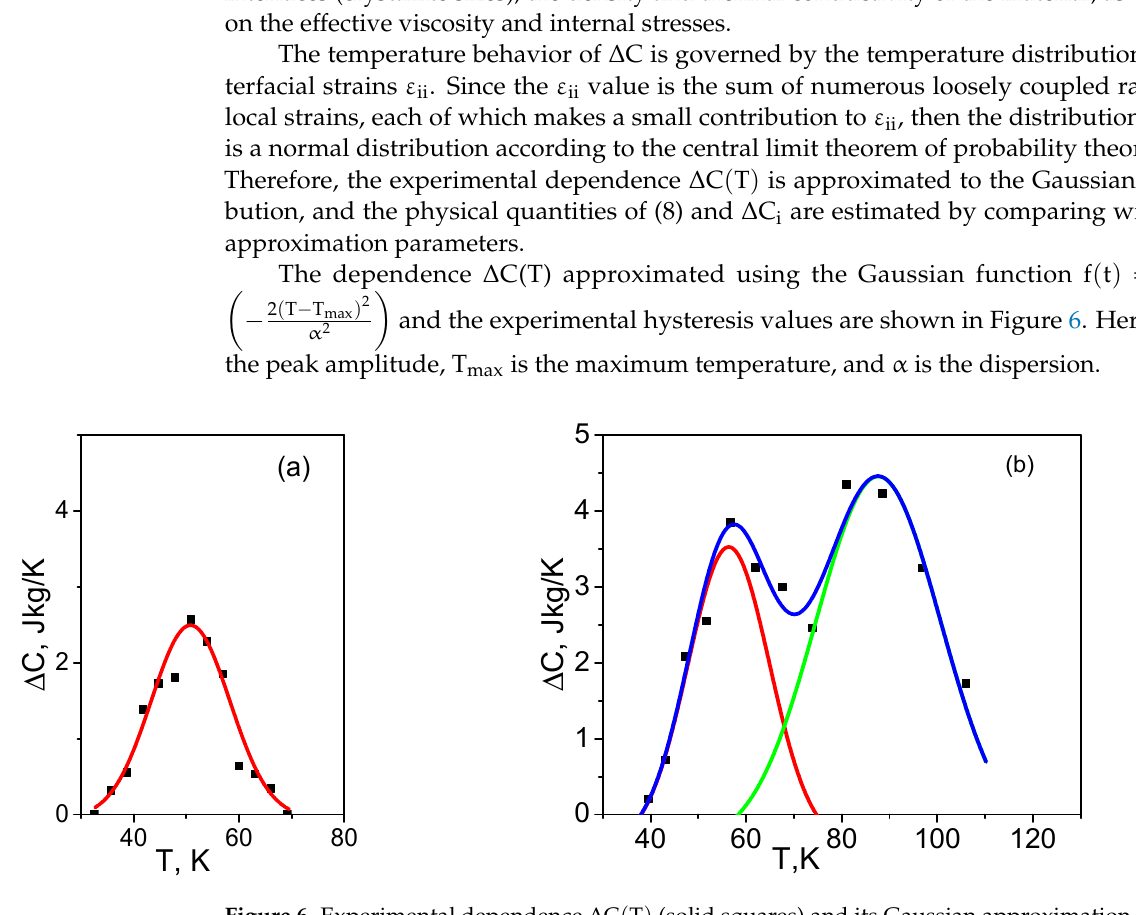
Figure 6. Experimental dependence ∆ C ( T ) (solid squares) and its Gaussian approximation of sam- ples S1 ( a ) and S2 ( b ).